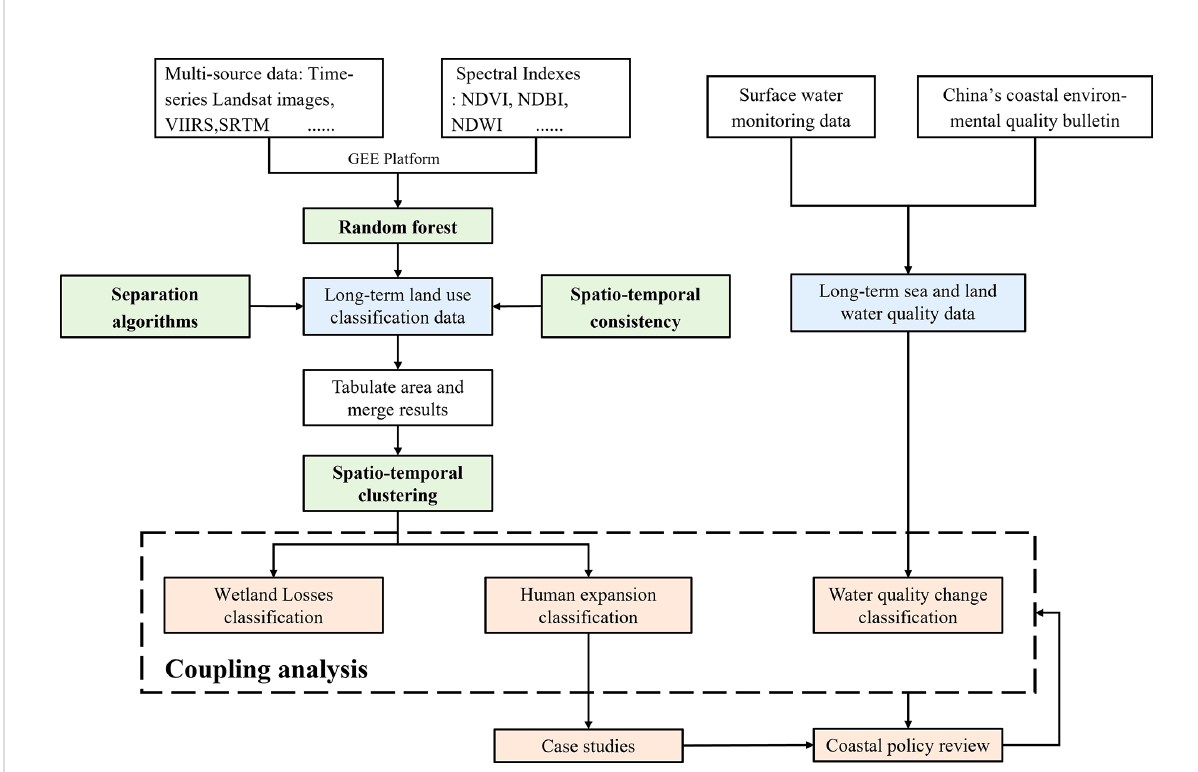
FIGURE 2 An integrative schematic of this study, including acquisition of core datasets (blue), processing of land use classi fi cation (green), and subsequent suggestive analysis (orange), which aimed to characterize the relationship between human expansion and environmental